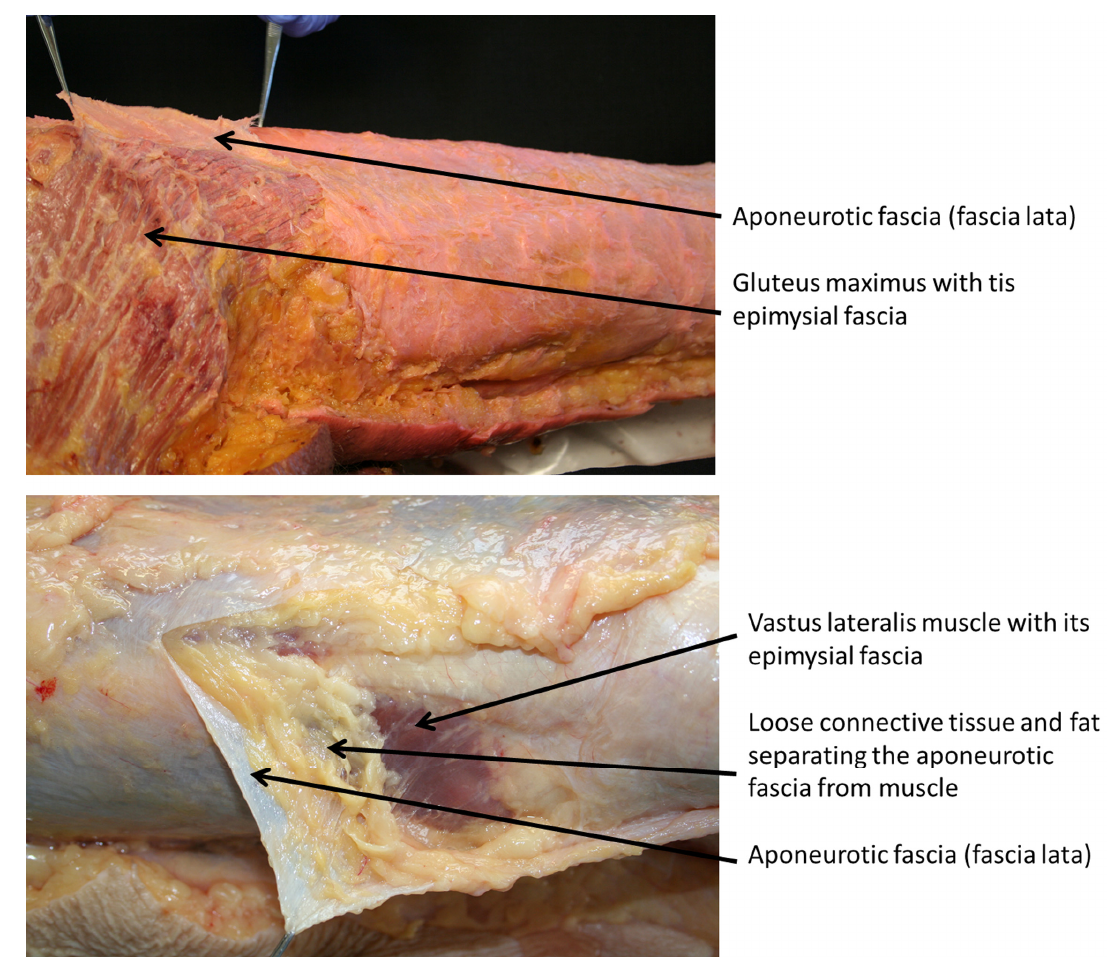
Figure 1. Epimysial and aponeurotic fasciae. In the first figure it is evident the fascia lata (aponeurotic fascia) easily separable from the gluteus maximum muscle. Note the adhesion of the gluteal fascia with its own muscle typical of the epimysial deep fascia. In the bottom figure, the fascia lata is separable from the vastus lateralis muscle thanks to loose connective tissue rich also in fat. In such way the fascia lata is mostly independent from the underline muscle.